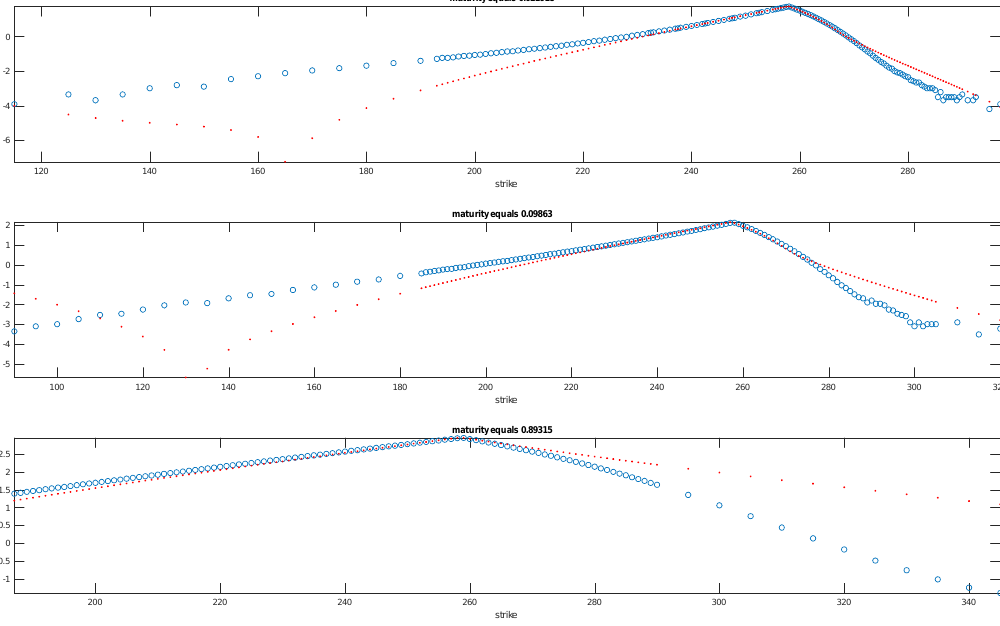
Figure 4. log out of the money option price fits at three difficult maturities. 10